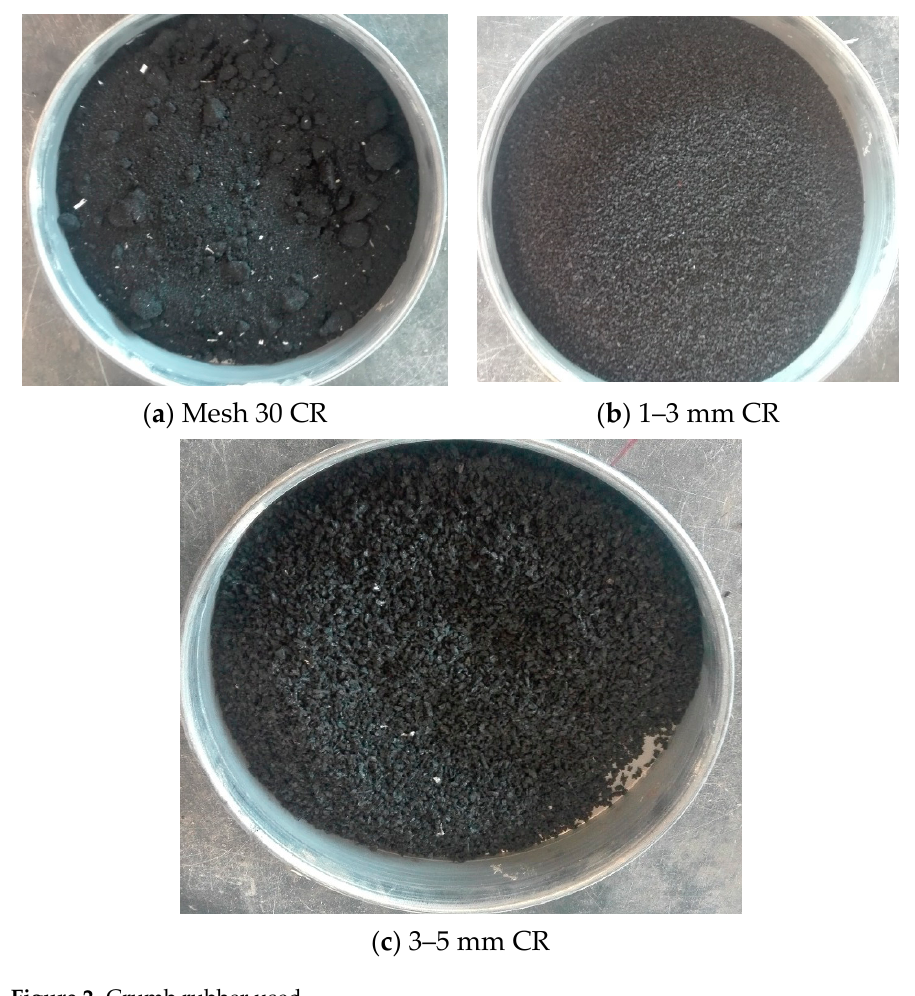
Figure 1. Aggregate’s particle size distribution.